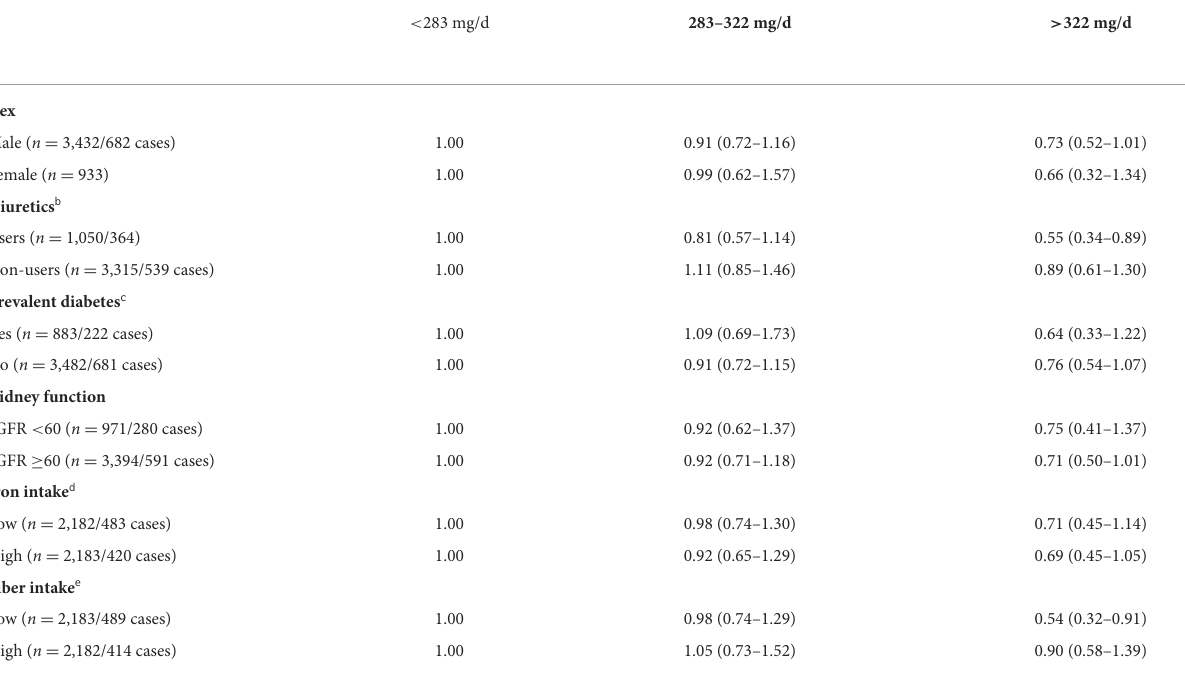
TABLE 3 HRs for energy adjusted magnesium intake in relation to CVD mortality in subgroups of post-MI patients from the Alpha Omega Cohort a . Tertiles of energy-adjusted magnesium